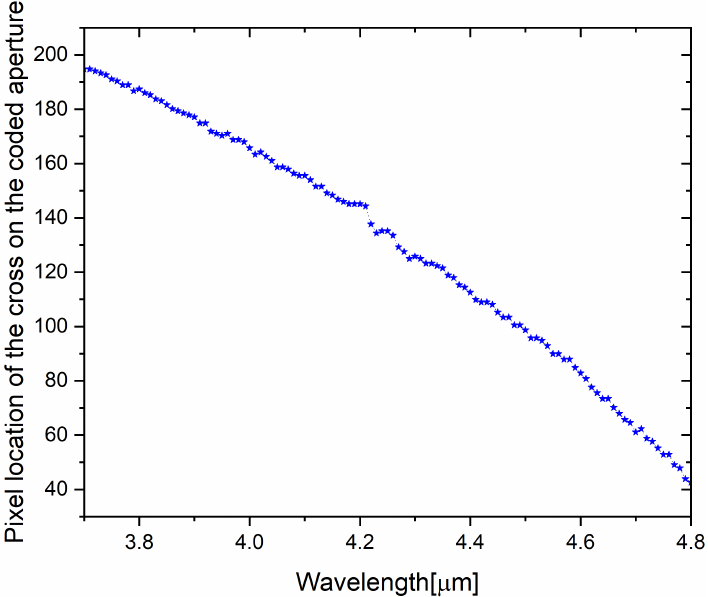
Figure 15. The blue dots denote the position of the cross at the top of the coded mask as a function of wavelength and show nonlinear dispersion through a